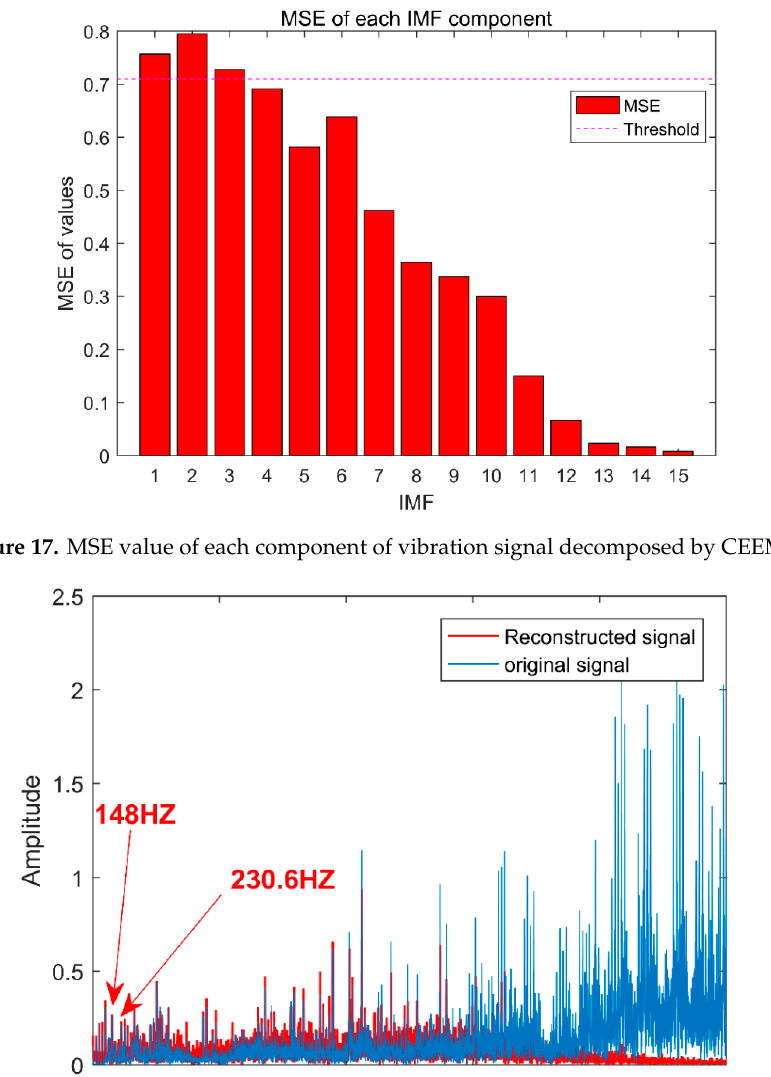
Figure 16. MSE value of 10,000 sets of random noise signals (the signal length is consistent with the vibration signal). Appl. Sci. 2020 , 10 , x